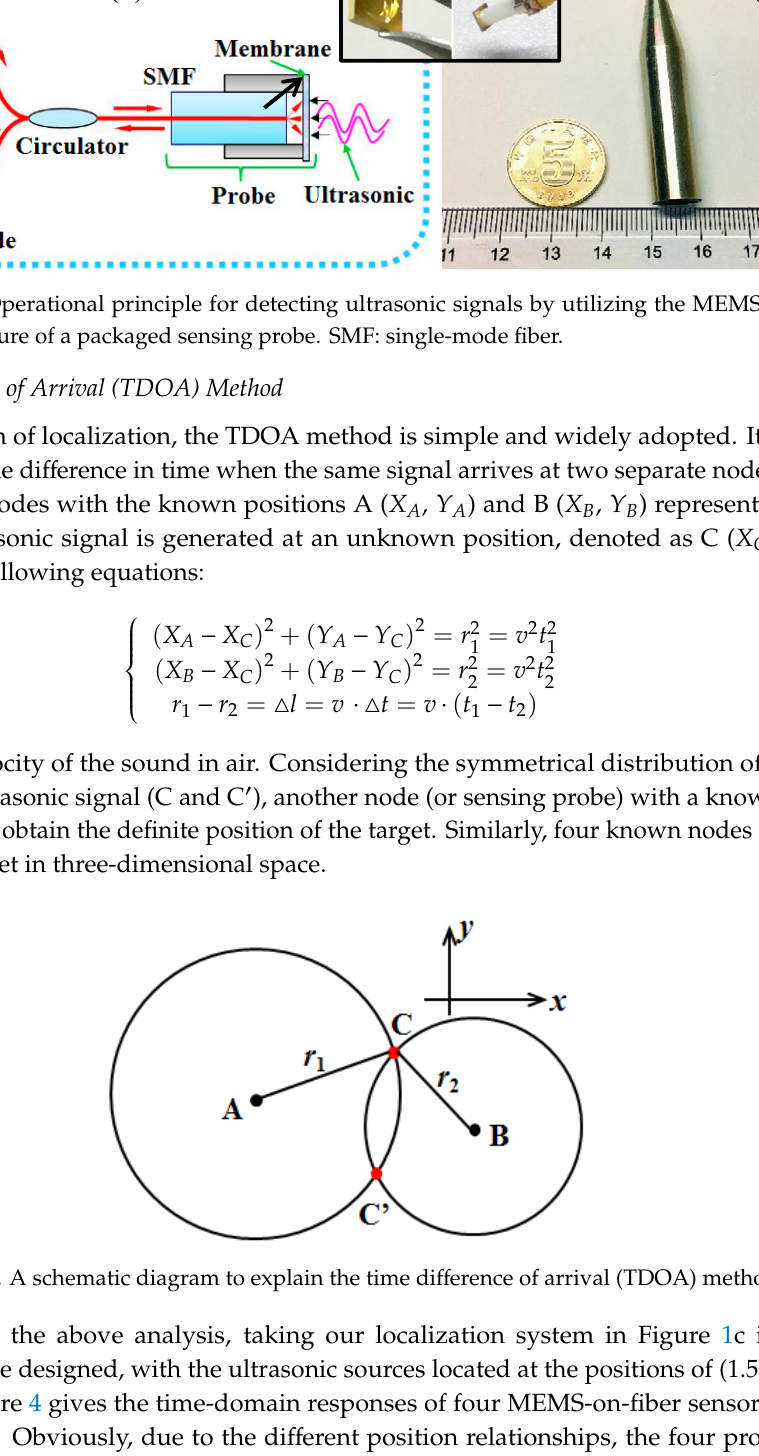
Figure 2. ( a ) Operational principle for detecting ultrasonic signals by utilizing the MEMS-on-fiber sensor. ( b ) Picture of a packaged sensing probe. SMF: single-mode fiber.